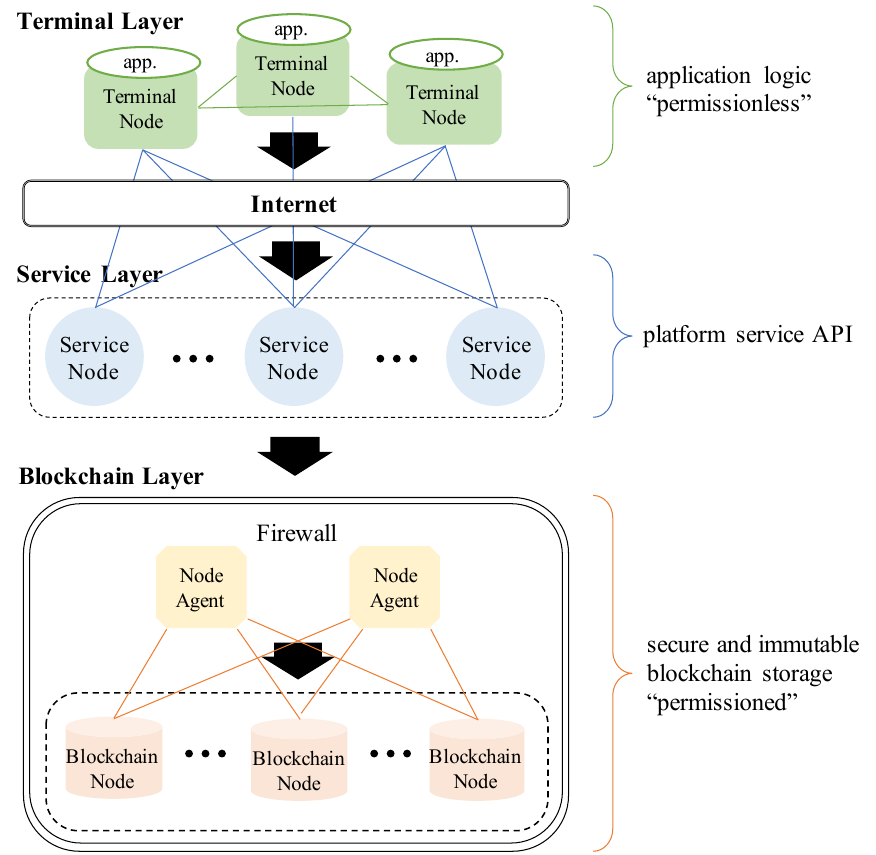
Figure 1. Three-layered Hierarchical Architecture of Doubly Decentralized Network Blockchain